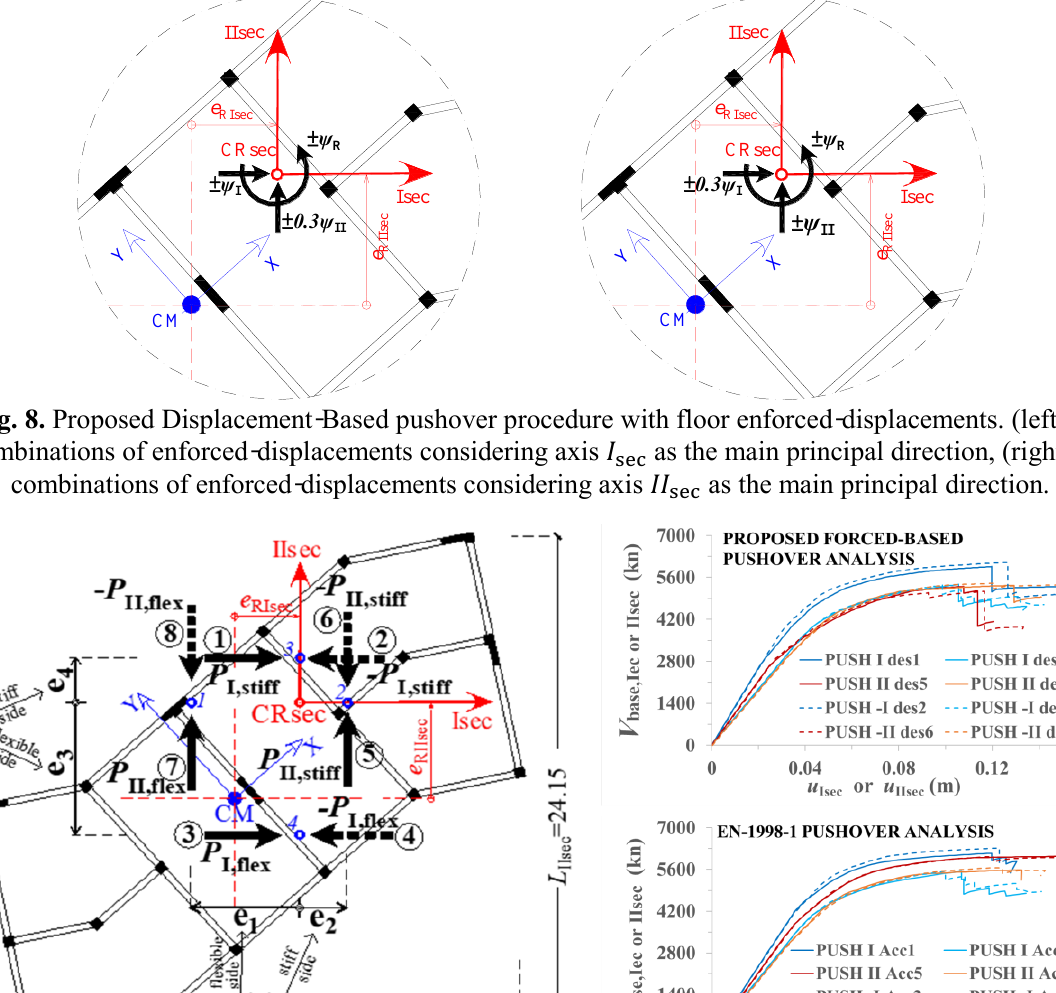
Fig. 9. Left: Proposed Force-Based pushover procedure using the inelastic design eccentricities, Right: Capacity Curves according to (up): the proposed Forced-Based pushover analysis, (down) EN 1998-1 pushover